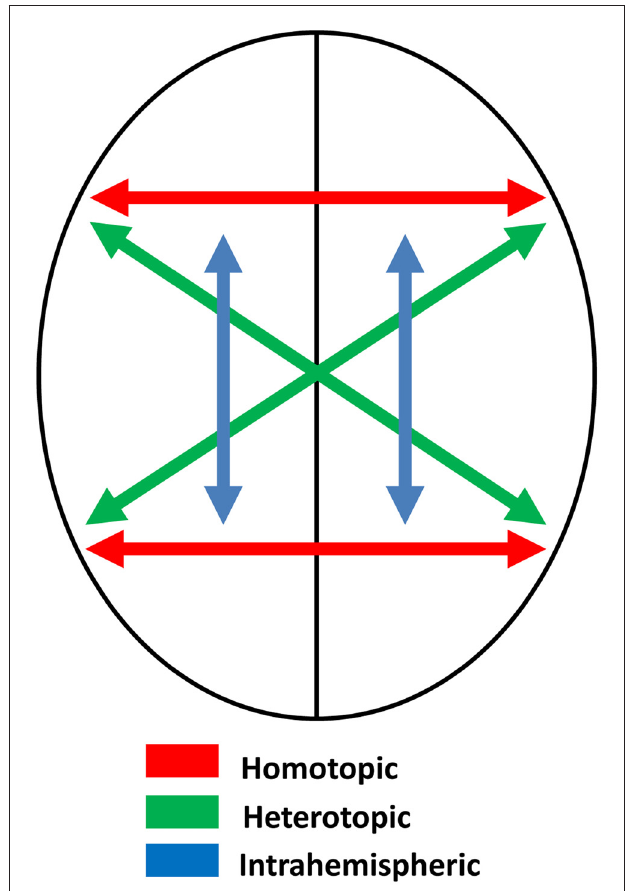
FIGURE 3 | Schematic diagram illustrating different kinds of neural connections in the brain: homotopic, heterotopic and intrahemispheric.